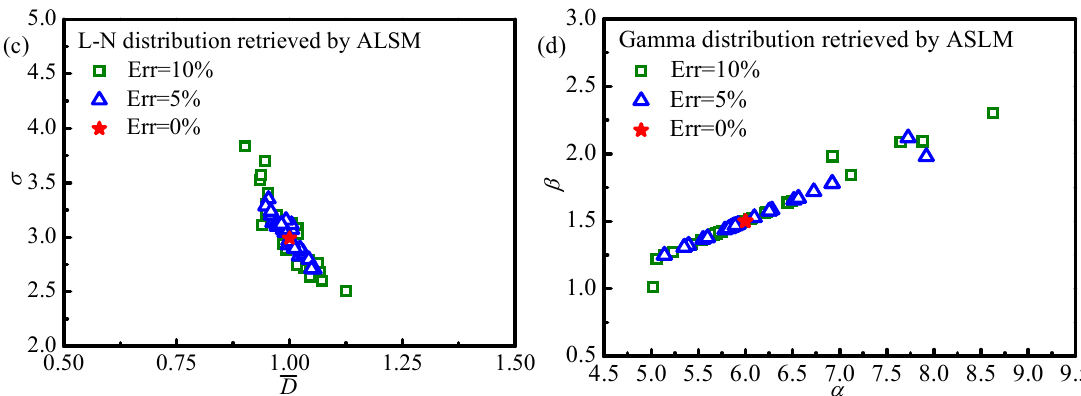
Figure 8. Distribution of retrieval results of monomodal ASDs for 30 calculations by using the SEM and ALSM: ( a ) and ( b ) for SEM; ( c ) and ( d ) for ALSM.